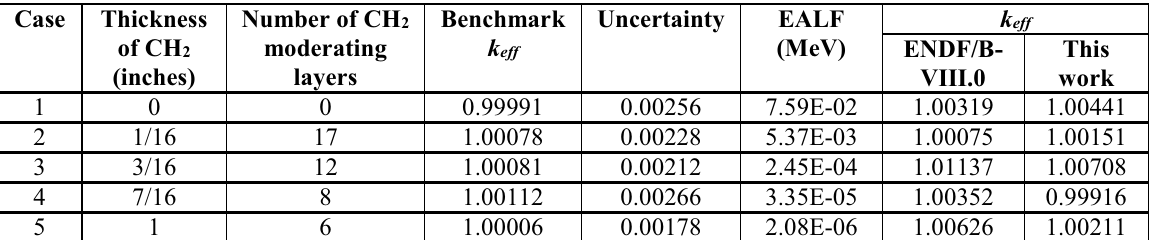
Table IV: Benchmark k eff results for TEX